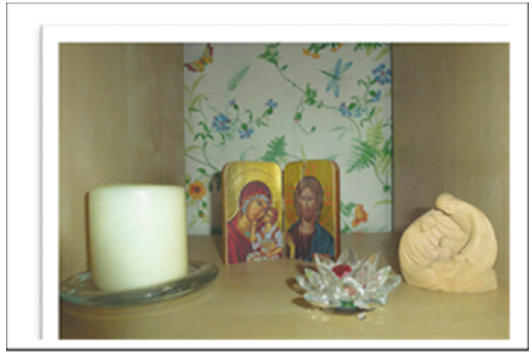
Figure 3. Photograph taken by Beth of her ‘shelf’.